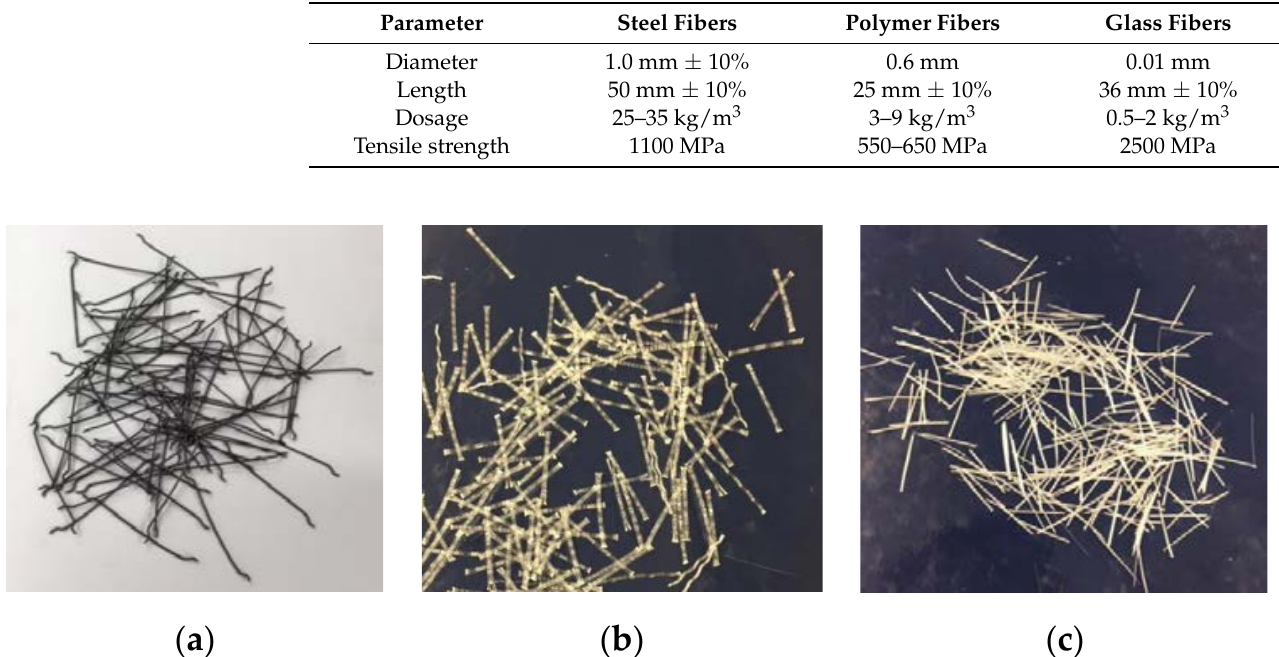
Figure 1. Fibers used: ( a ) steel, ( b ) polymer, ( c ) glass.